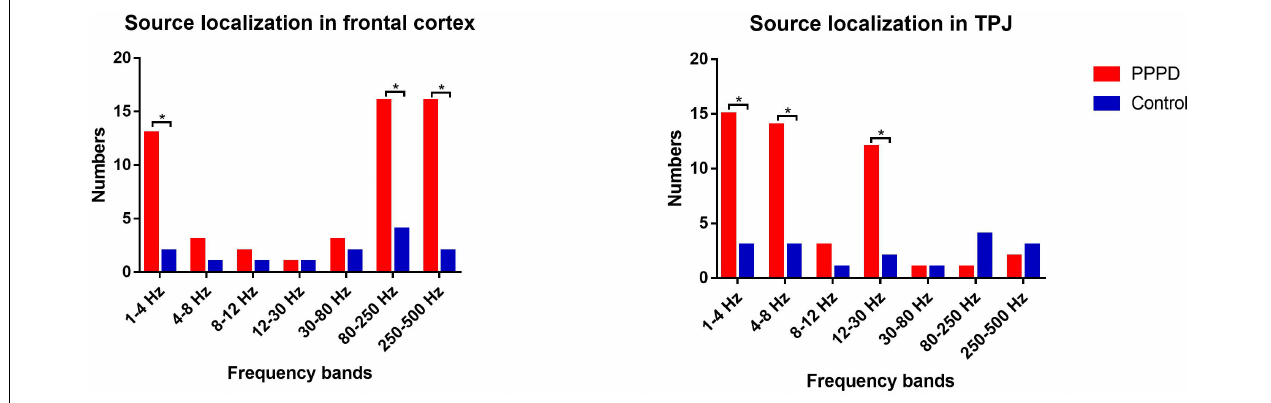
FIGURE 3 | Difference in the number of neuromagnetic source localization between PPPD patients and the controls in seven frequency bands. The number of source locations is located on the y -axis. Seven frequency bands are listed on the x -axis. * p < 0.05 after Bonferroni correction.